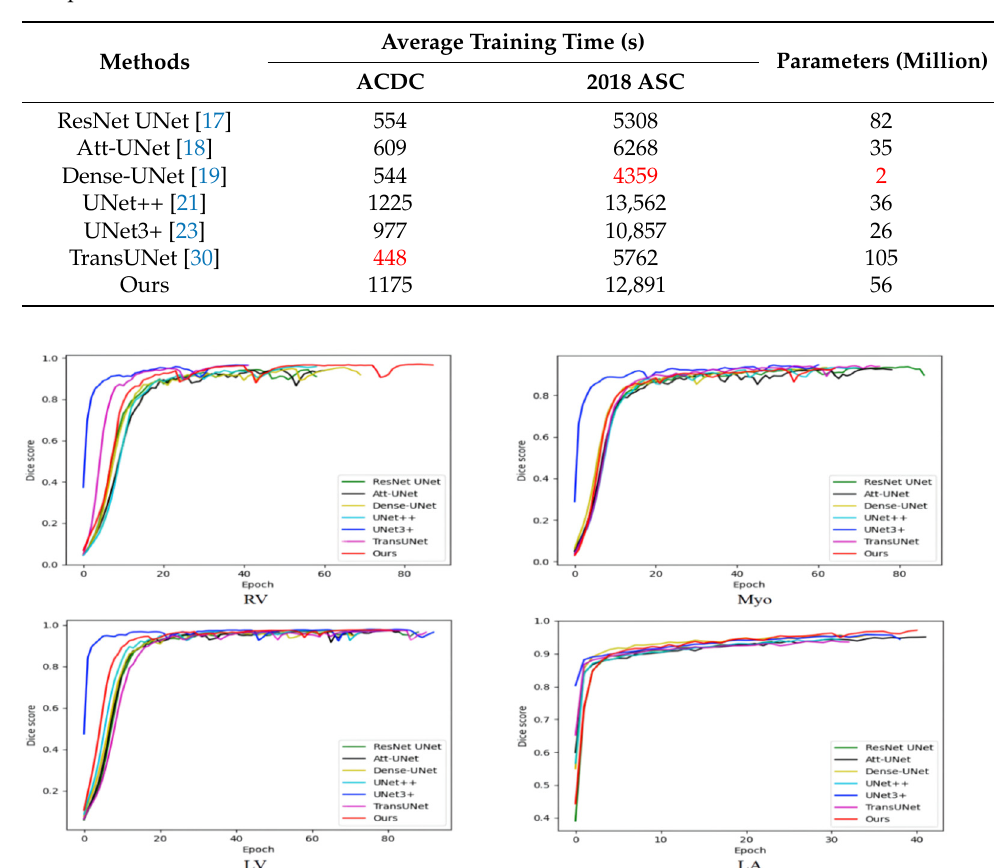
Figure 7. Comparison of right ventricle (RV) segmentation results. Figure 8. Comparison of myocardium (Myo) segmentation results.